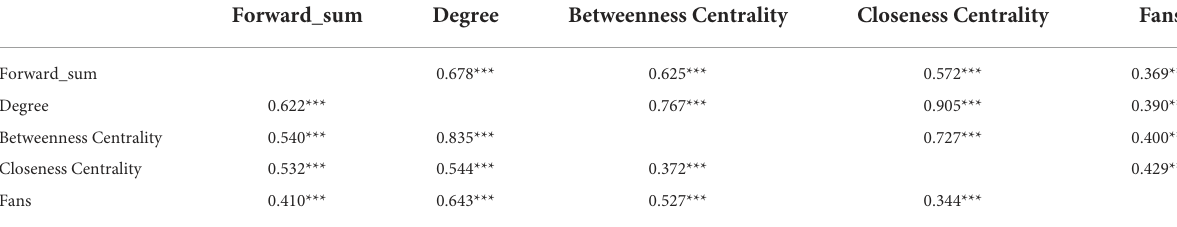
TABLE 7 Bivariate correlation analysis of social network analysis model.